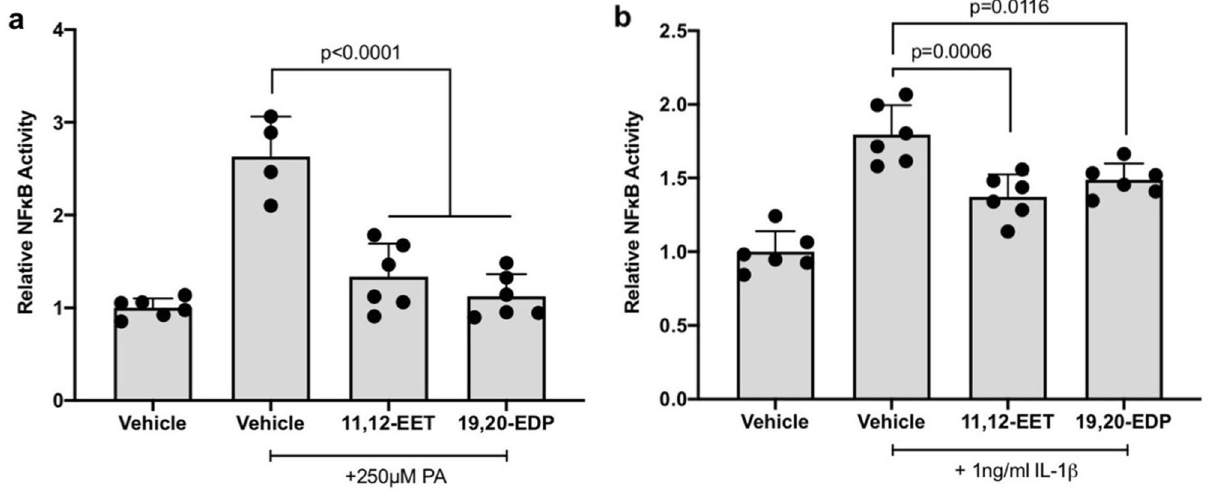
Figure 6. The effect of 11,12-EET or 19,20-EDP on PA or IL-1β-induced NFκB promoter activity. hMC were transfected with a NFκB-luciferase reporter construct and treated with ( a ) PA ( b ) IL-1β or in the presence or absence of 11,12-EET (0.5 μM) or 19,20-EDP (0.5 μM). NFκB activity was determined by measuring the ratio of firefly-to-renilla luciferase luminescence activity. Each bar represents the mean ± SD (n = 4, 5 or